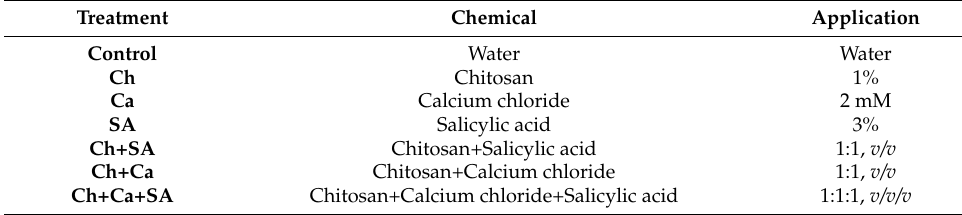
Table 1. Preharvest spry treatments of ‘Khesab’ date fruit with different